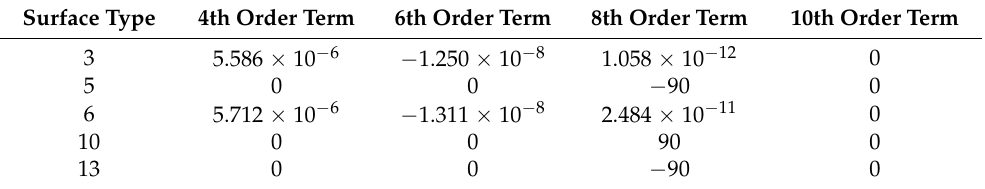
Table 3. Structural parameters of spherical cylindrical-lens-combined optical focusing system. Surface